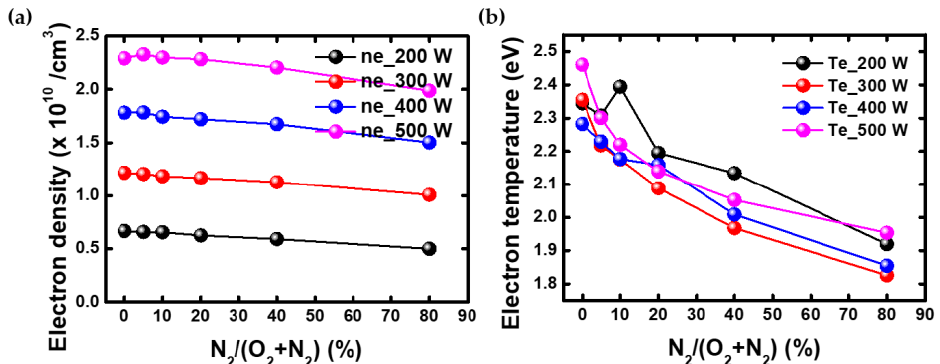
Figure 6. These are plasma parameters obtained by the EEPF as power variation. ( a ) electron den- sity, ( b ) electron effective temperature.